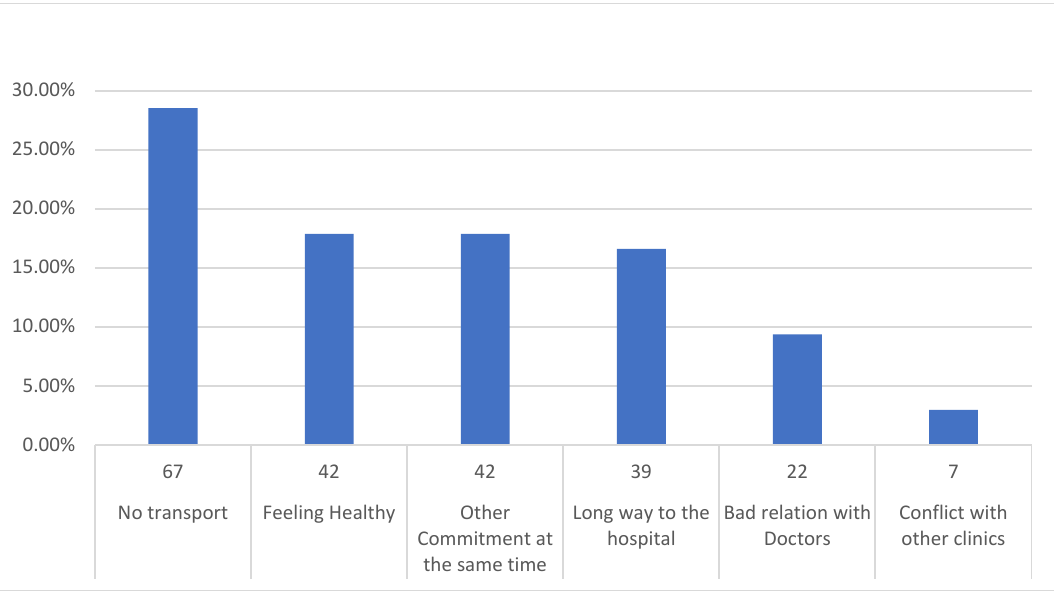
Figure 4. Factors that improve clinic attendance for participants with SCD.